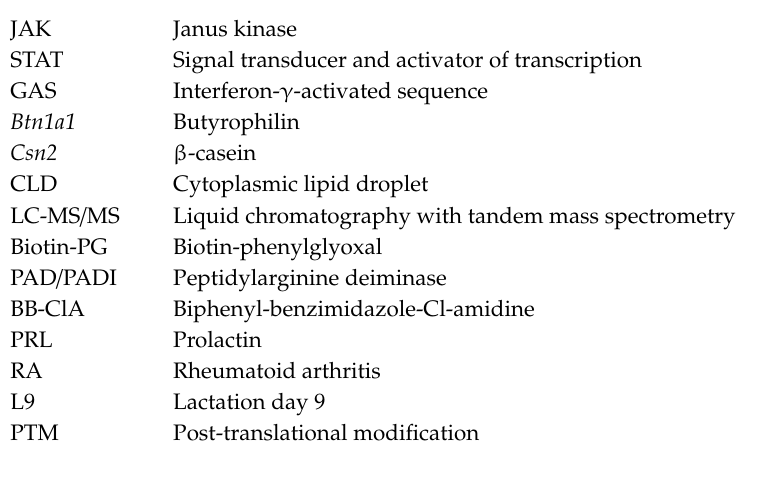
s1. Table S1. Citrullinated proteins identified by LC-MS / MS. The full list of citrullinated (cit) proteins (107), proteins found in cit and control samples (35), and found only in control samples (7) using biotin-phenylglyoxal enrichment of citrullinated